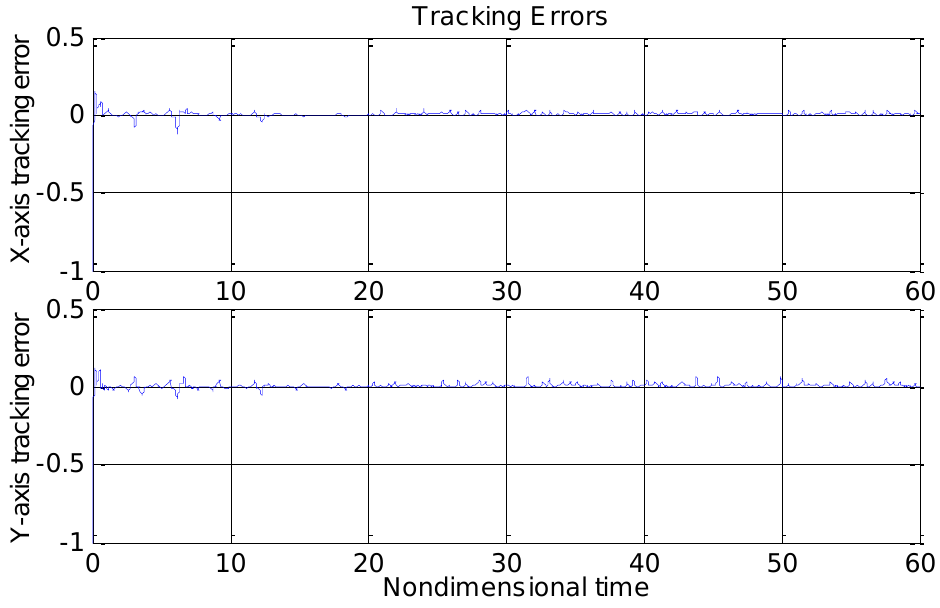
Figure 7. Tracking errors using ABC under step disturbances without robust term.